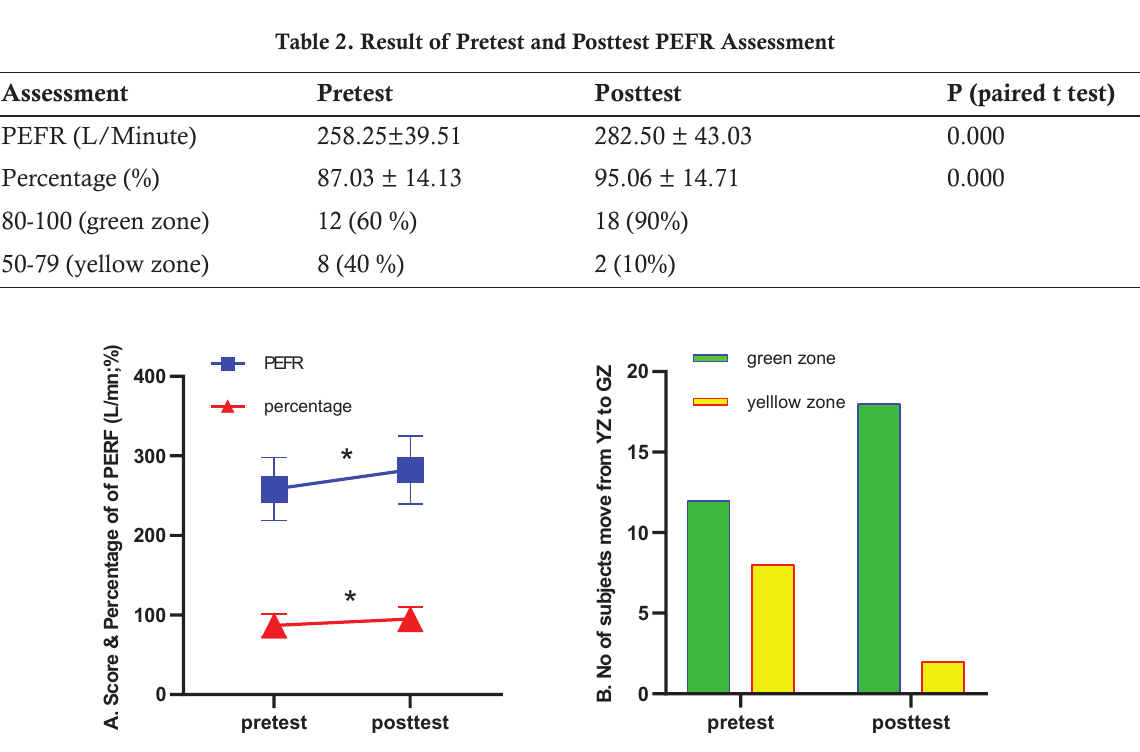
Figure 1. A. The difference score of PEFR in pretest and posttest; B the difference Figure 1 . A. The difference score of PEFR in pretest and posttest; B the difference PEFR percentage in pretest PEFR percentage in pretest and posttest. Paired t test: * and posttest. Paired t test: * p<0.05 Figure 1 . A. The difference score of PEFR in pretest and posttest; B the difference PEFR percentage in pretest Figure 1 . A. The difference score of PEFR in pretest and posttest; B the difference PEFR percentage in pretest and posttest. Paired t test: * p<0.05 and posttest. Paired t test: * p<0.05